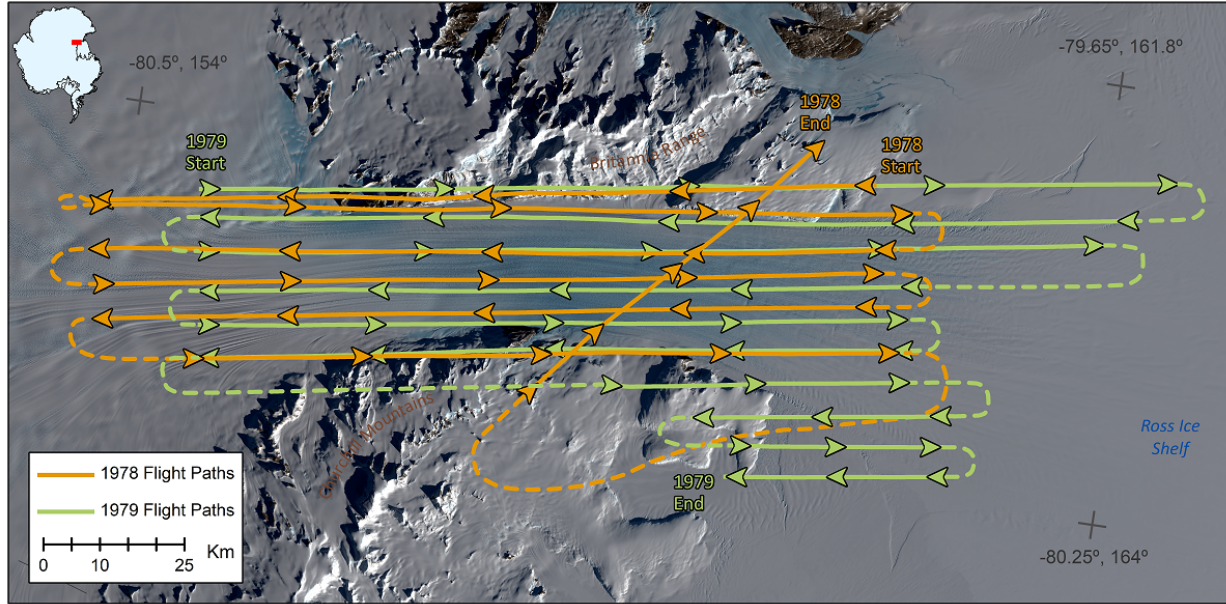
Figure 1. Map of Byrd Glacier with the 1978 and 1979 flight paths. The solid lines represent where aerial images were collected and the dashed lines show where the planes turned around. The direction of ice flow for this figure and all following figures is from left to right of the figure. The background image is a band combination composite of Bands 3, 4, and 5 from Landsat-8 OLI images LC80471192019048LGN00 and LC80471182019048LGN00 (also used for all following figures with maps). The inset map in the upper left corner denotes Byrd Glacier’s location in